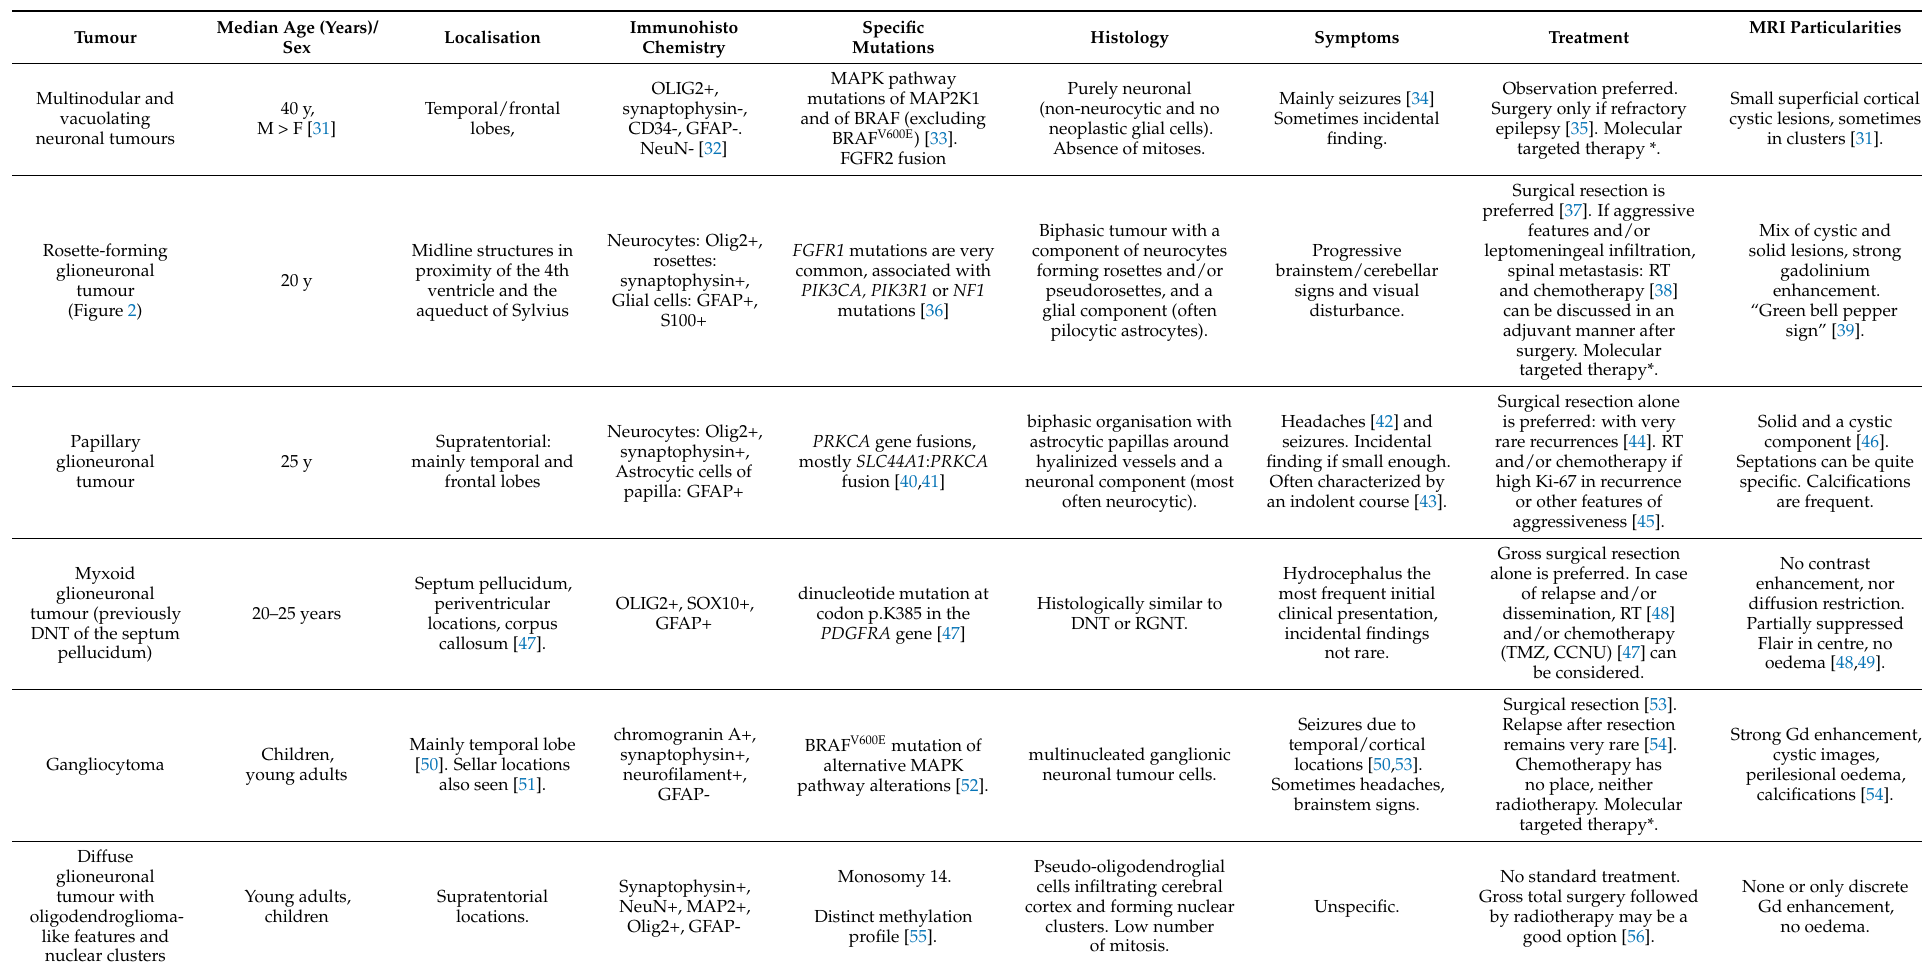
Table 1. Main characteristics of some rare predominantly glioneuronal and neuronal tumours (WHO grade 1 and